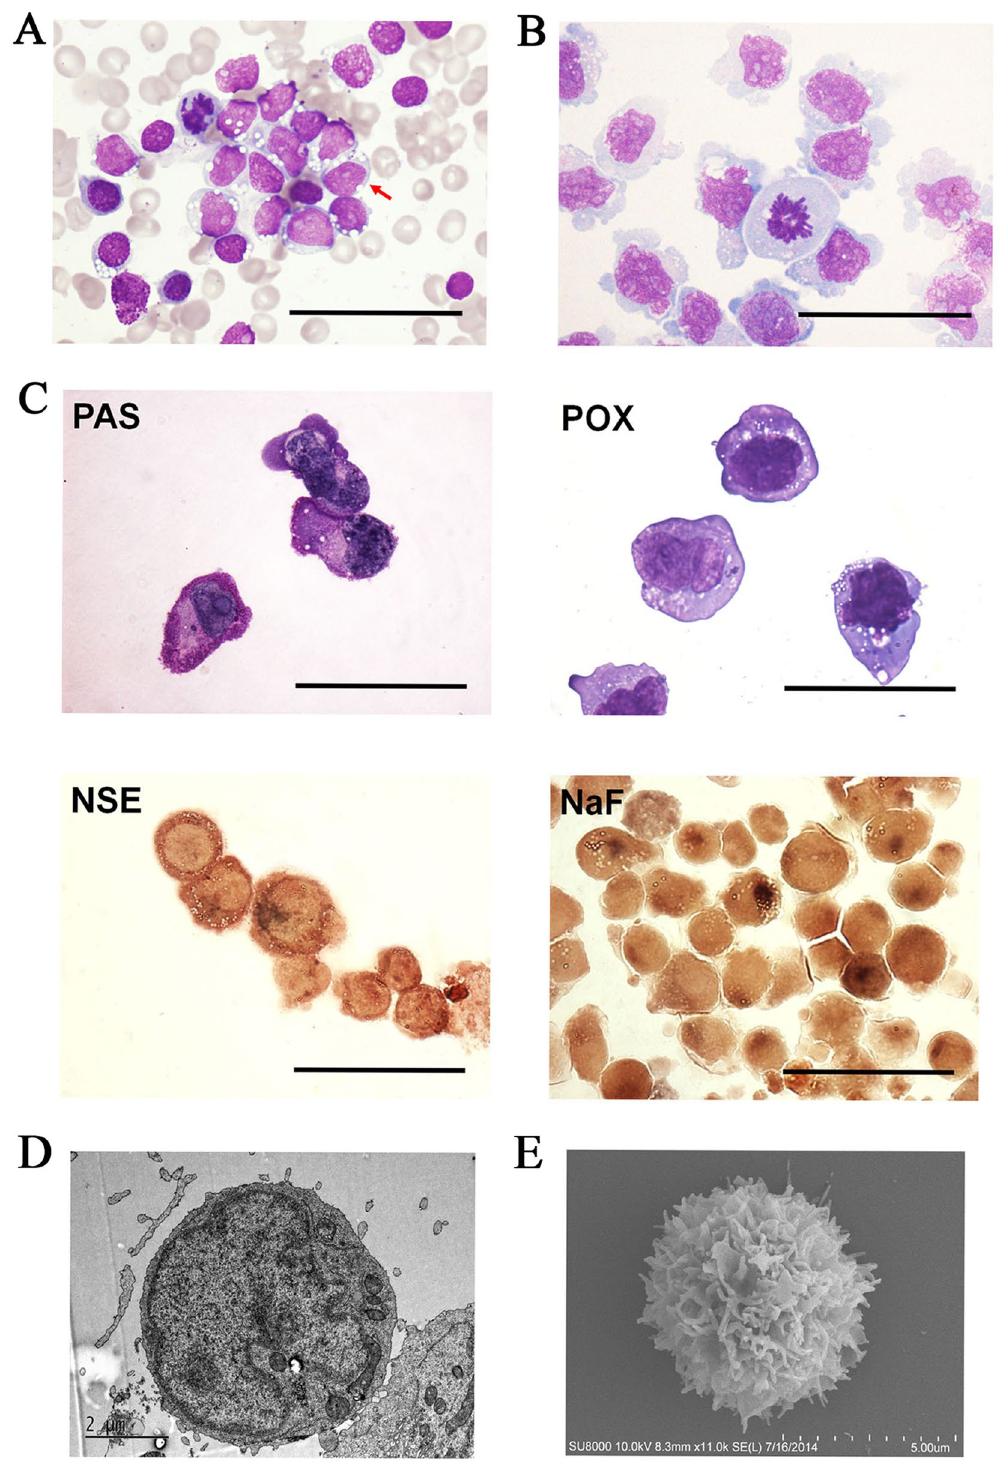
Figure 1. Morphology of CHH-1 cells. Wright’s stains of ( A ) primary leukemia cells in bone marrow of the patient and ( B ) CHH-1 cells. The cells have a blastic appearance with immature nuclei, prominent nucleoli and gray blue cytoplasm with vacuoles, similar to the original leukemia cells. ( C ) Cytochemical staining of CHH-1 cells. ( D ) Ultrastructural appearance of a CHH-1 cell illustrating a deep-folded nucleus with well-defined nucleolus and cytoplasm containing few organelles except a number of mitochondria and rough endoplasmic reticulum. ( E ) Scanning electron microscopy of CHH-1 cells showing abundant microvili. Original magnification × 1000, scale bar 50 μ m ( A , B , C